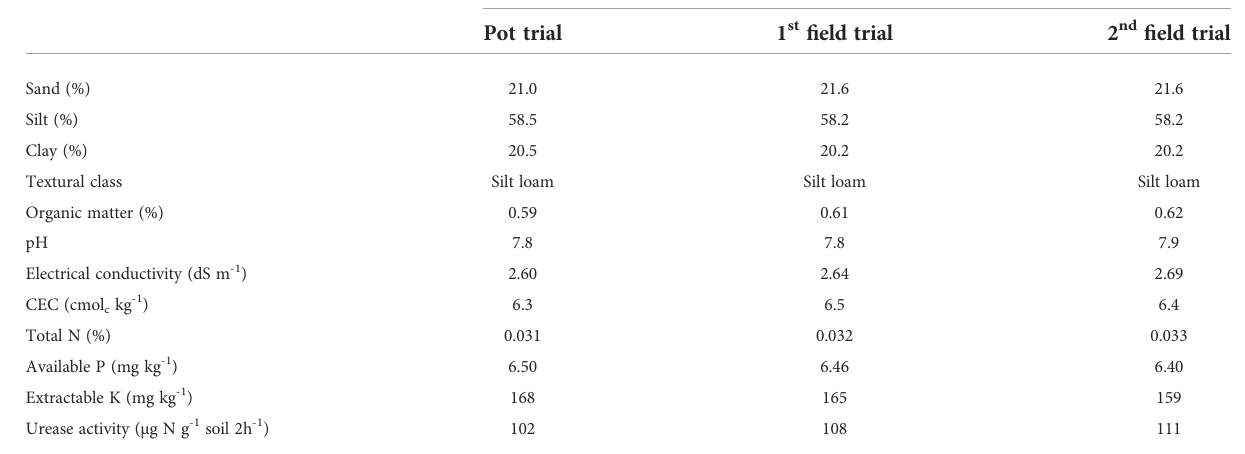
TABLE 1 Physical and chemical properties of soils.